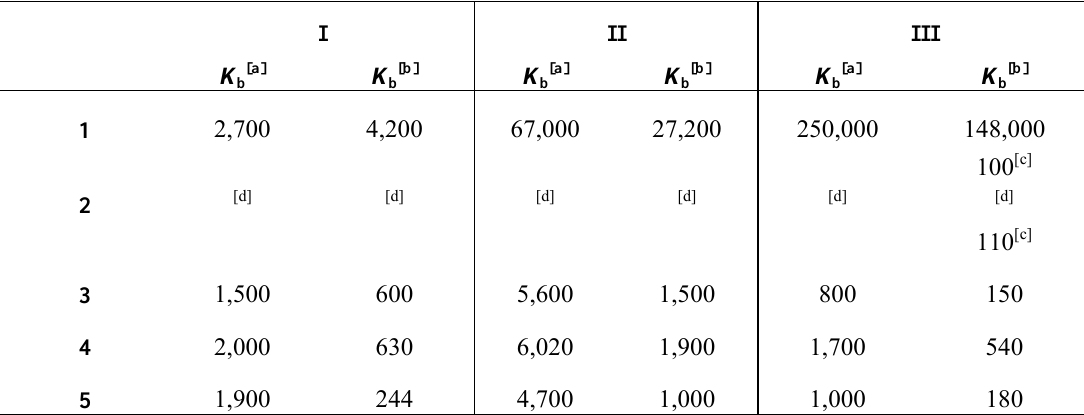
(M –1 ) for I – III binding 1 – 5 measured at 300 K in CDCl b